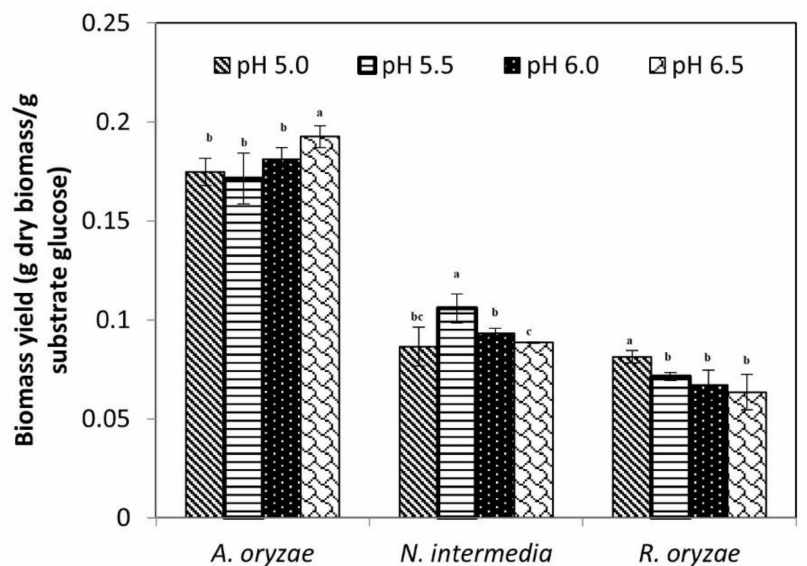
Figure 1. Biomass yield (g dry biomass/g substrate glucose) of A. oryzae , N. intermedia and R. oryzae on semi-synthetic medium in different initial pH (5.0, 5.5, 6.0 and 6.5). Different letters indicate statistically significant differences among experimental groups ( p < 0.05). Values are presented as